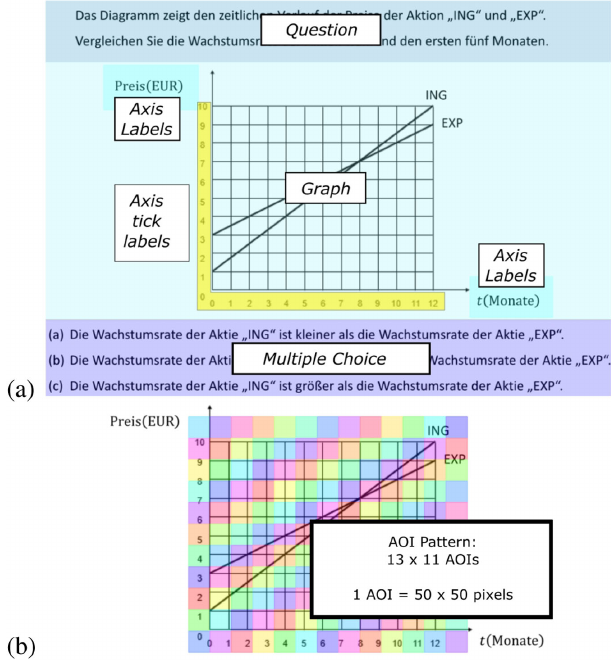
FIG. 2. (a) Definition of AOIs for one item. (b) AOI pattern covering the diagram (without axis labels) for the same